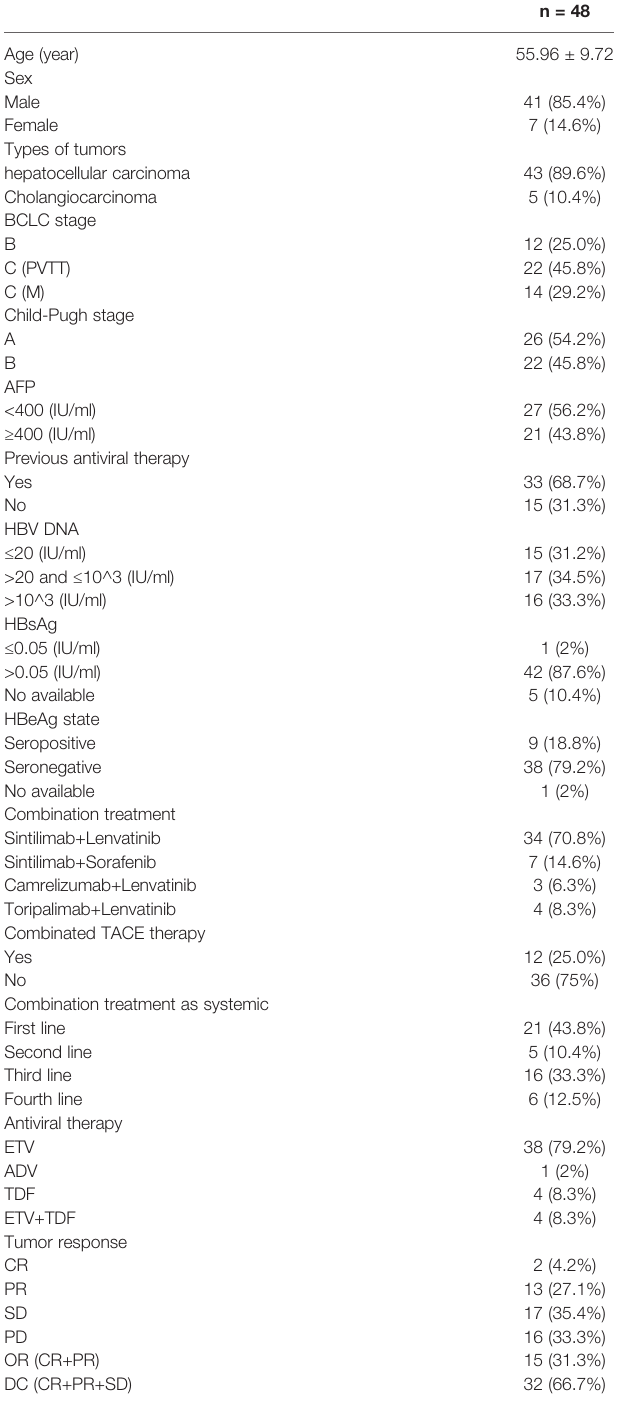
TABLE 1 | Baseline characteristics of patients enrolled in the